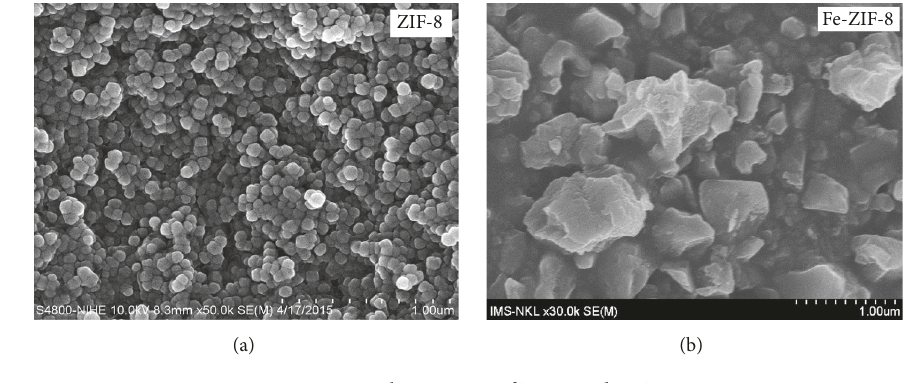
Figure 2: SEM observations of ZIF-8 and Fe-ZIF-8. Table 1: Chemical composition of ZIF-8 and Fe-ZIF-8 analyzed by AAS and XPS.